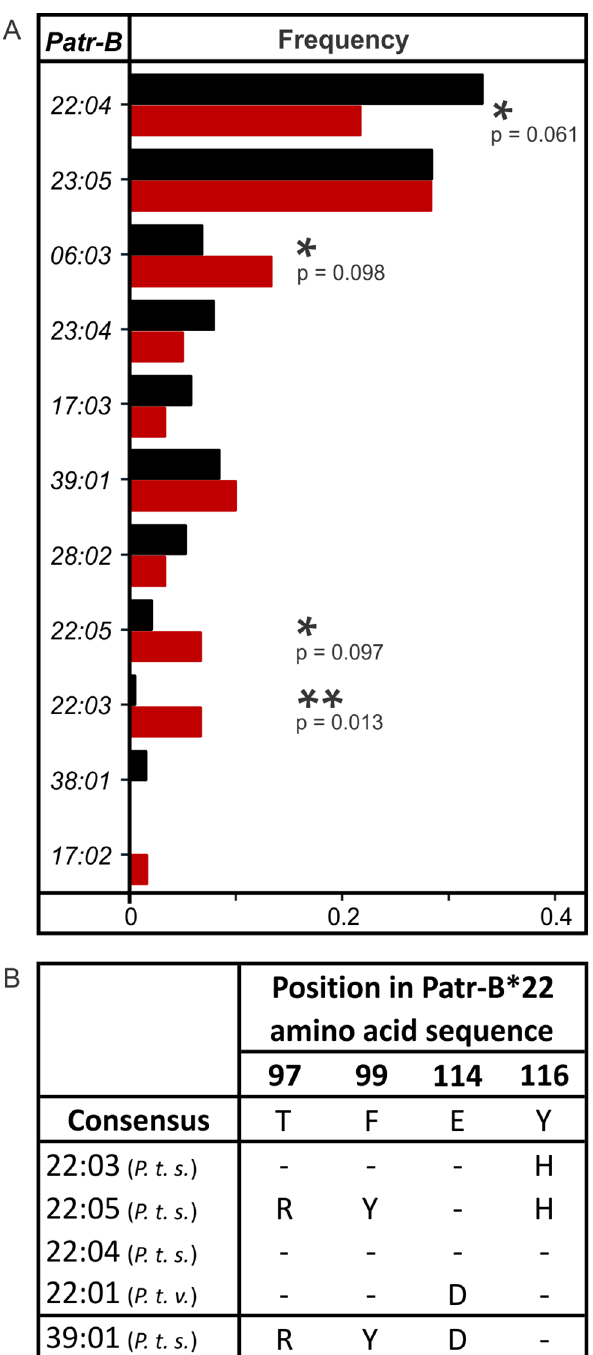
Fig 7. In the Gombe chimpanzees, SIVcpz infection correlates with increased frequencies for three Patr-B alleles. (A) Comparison of Patr-B allele frequencies in SIVcpz-infected and uninfected Gombe chimpanzees. The Patr-B*06:03, B*22:03, and B*22:05 alleles are at elevated frequency in the SIVcpz- infected chimpanzees. In contrast, the frequency of Patr-B*22:04 is lowered in the SIVcpz-infected chimpanzees. Asterisks denote differences between the SIVcpz-infected (red) (N = 30) and uninfected (black) (N = 95) subpopulations (Fisher ’ s Exact tests, p -values given underneath the asterisks * p < 0.1 and ** p < 0.05). The frequencies for this figure are provided in S3 Data. (B) Sites of amino acid difference that distinguish Patr-B*22 subtypes. “ P.t.s. ” is P. t. schweinfurthii ; “ P.t.v. ” is P. t. verus . Patr-B*39:01 is included because it has structural similarities with Patr-B*22, including an α 1 domain that is identical to that of Patr- B*22:03 and